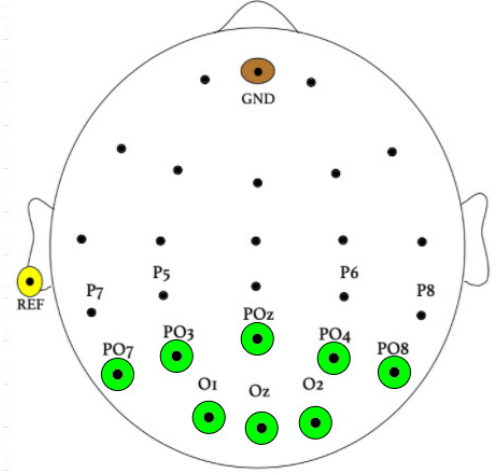
Figure 3. Electrode placement during